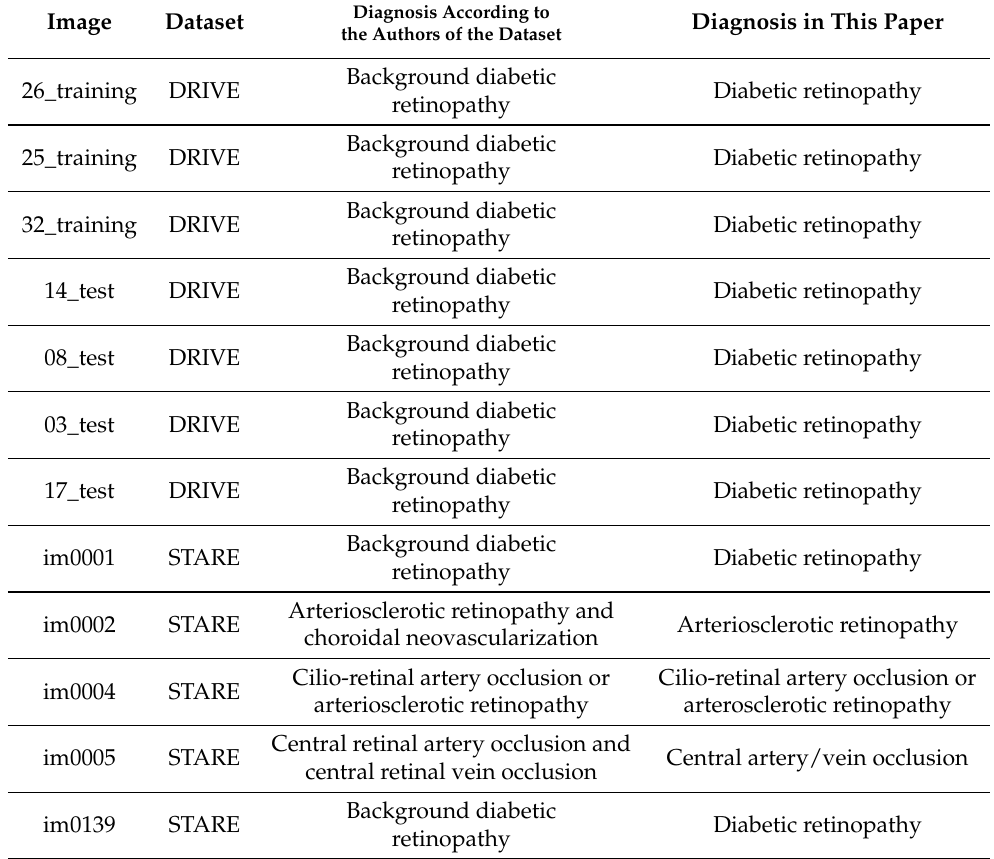
Table 2. A list of fundus images whose corresponding segmentation masks are included in the survey. The table includes the image name that matches what it was named in the publicly available dataset (the first column). The dataset name (the second column), the diagnosis associated with the image according to ground truth values provided by the authors of the corresponding dataset (the third column), and the diagnostic category are listed, as in the survey (the last